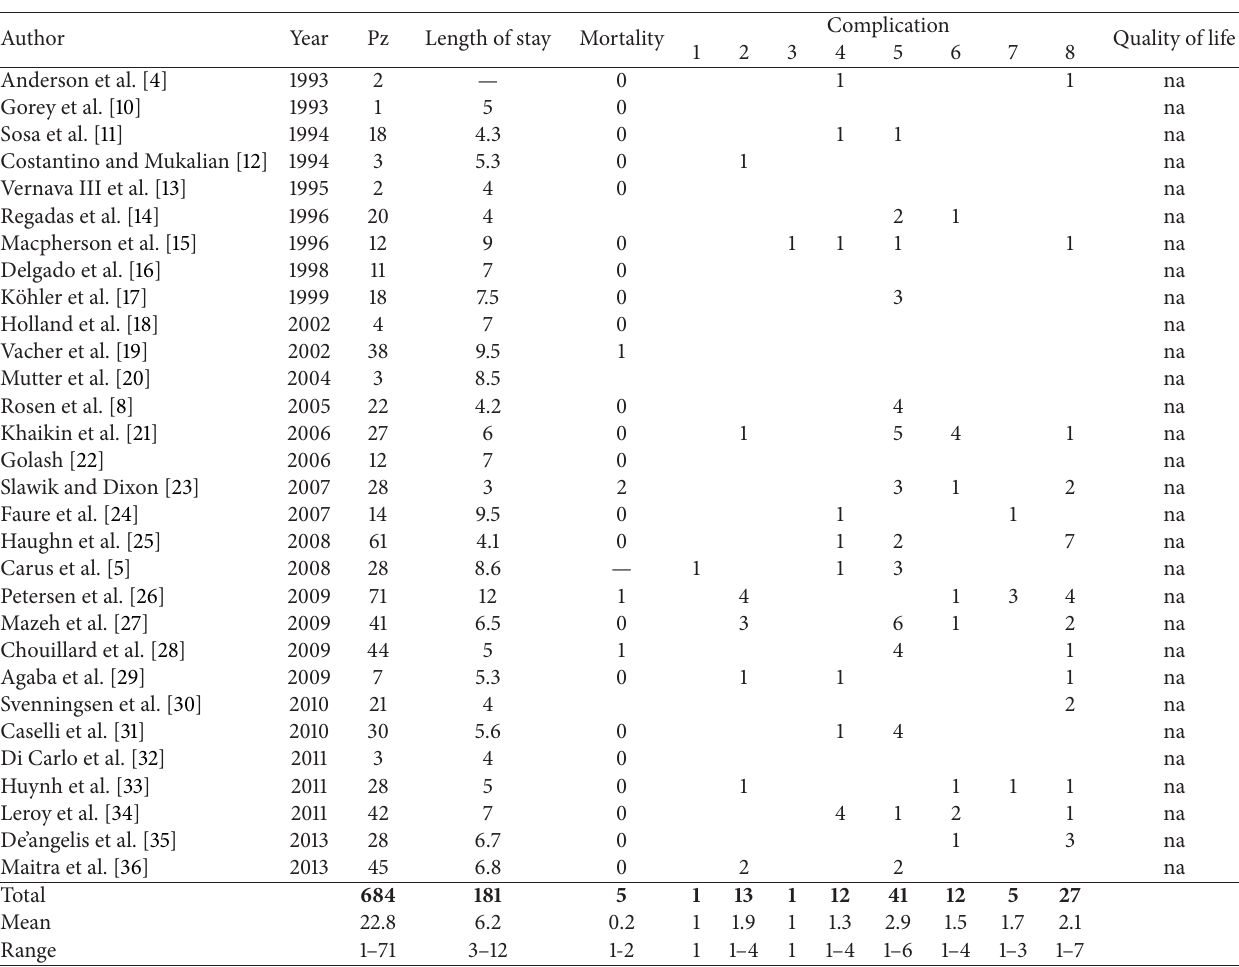
Table 3: Postoperative